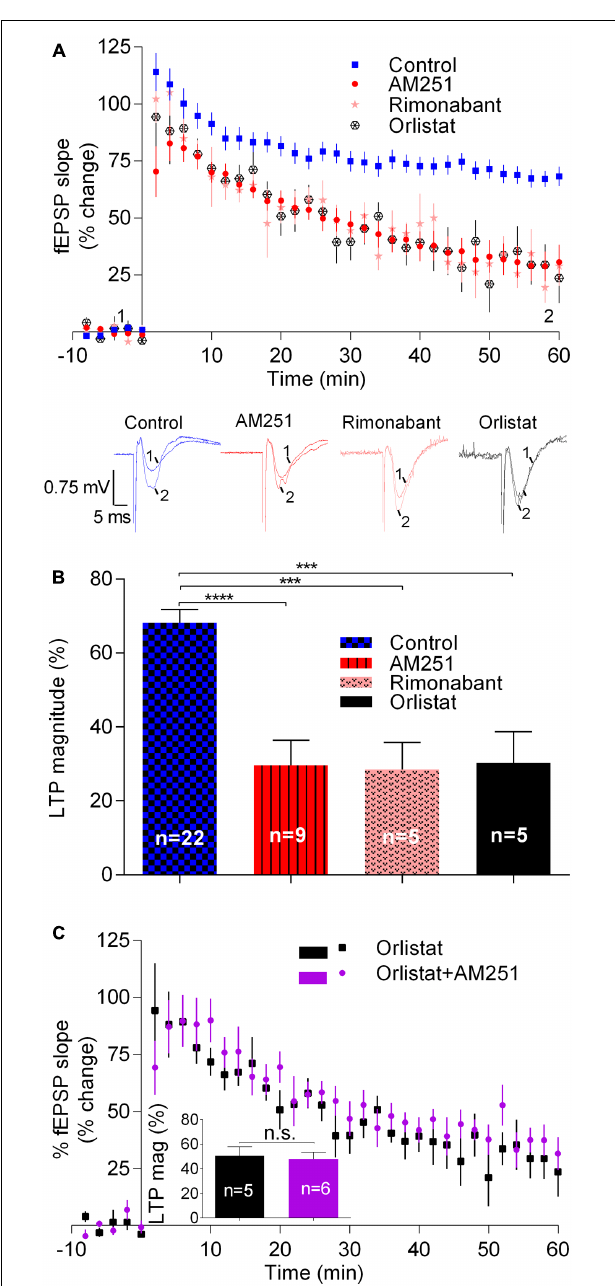
FIGURE 2 | Endocannabinoids enhance LTP induced by strong- θ -burst stimulation (10 trains of 100 Hz, 4 stimuli, separated by 200 ms). (A) Time course of the averaged fEPSP slopes, and original traces of fEPSP recordings, in control conditions (no drugs) or in the presence of 1 µ M AM251 (CB 1 R inverse agonist), 1 µ M Rimonabant (CB 1 R antagonist), or 10 µ M Orlistat (a fatty acid synthesis inhibitor). (B) Quantification of LTP magnitude under the indicated drug conditions. ∗∗ p < 0.01; ∗∗∗ p < 0.001 ( F ( 7 , 91 ) = 11.0, one-way ANOVA with Sidak’s correction). (C) Non-additivity of the inhibitory effect of AM251 and Orlistat, when added together. ns: p > 0.05 ( F ( 4 , 5 ) = 1.4, Student’s t -test). Data for Orlistat in (A) and (C) (time course) and in (B) and (C) (LTP magnitude) are repeated to allow comparison between the action of Orlistat in the absence or presence of AM251. For further details see legend to Figure 1